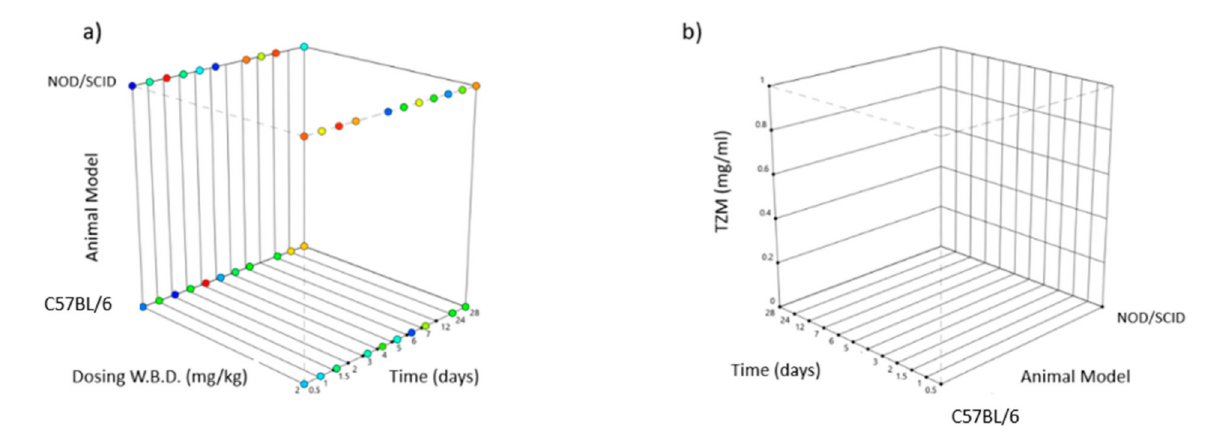
Figure 4. Box diagram showing the experimental design [48] for various factors [49]: ( a ) y -axis type of animal model categorical NOD/SCID/J (top) and C57BL/6/J (below), x -axis W.B.D. dosing in mg/kg, z -axis time in days, ( b ) y -axis TZM blood concentration in mg/mL, x -axis time in days, z -axis type of animal model C57BL/6/J (left) and NOD/SCID/J